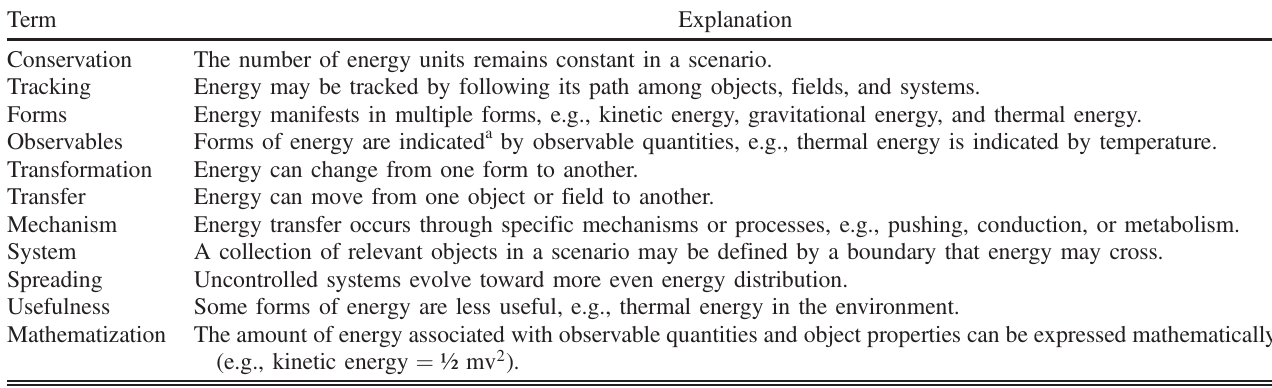
TABLE I. Eleven constituent ideas comprising the NGSS model of energy in the physical